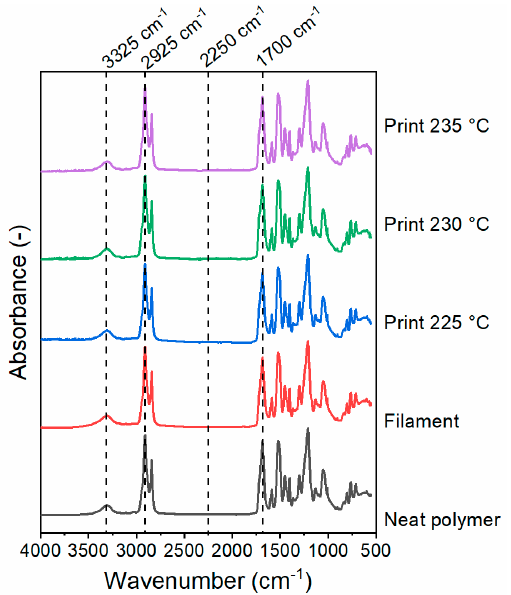
Figure 3. FTIR spectra of the SH-TPU as produced (neat polymer), as filament and as 3D printed polymer at different printing temperatures (225, 230 and 235 °C).